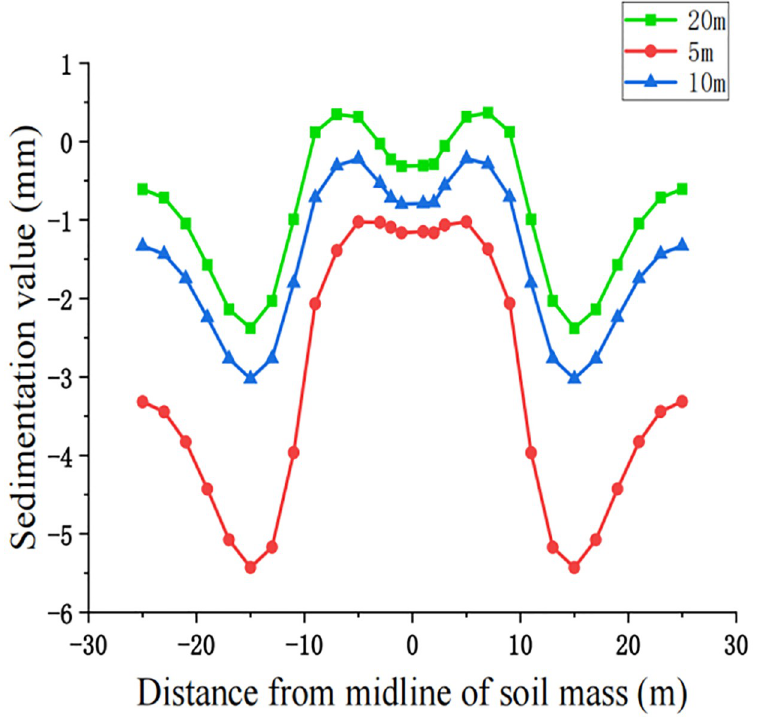
Fig 14. Surface deformation curves of loess-like soil under three working